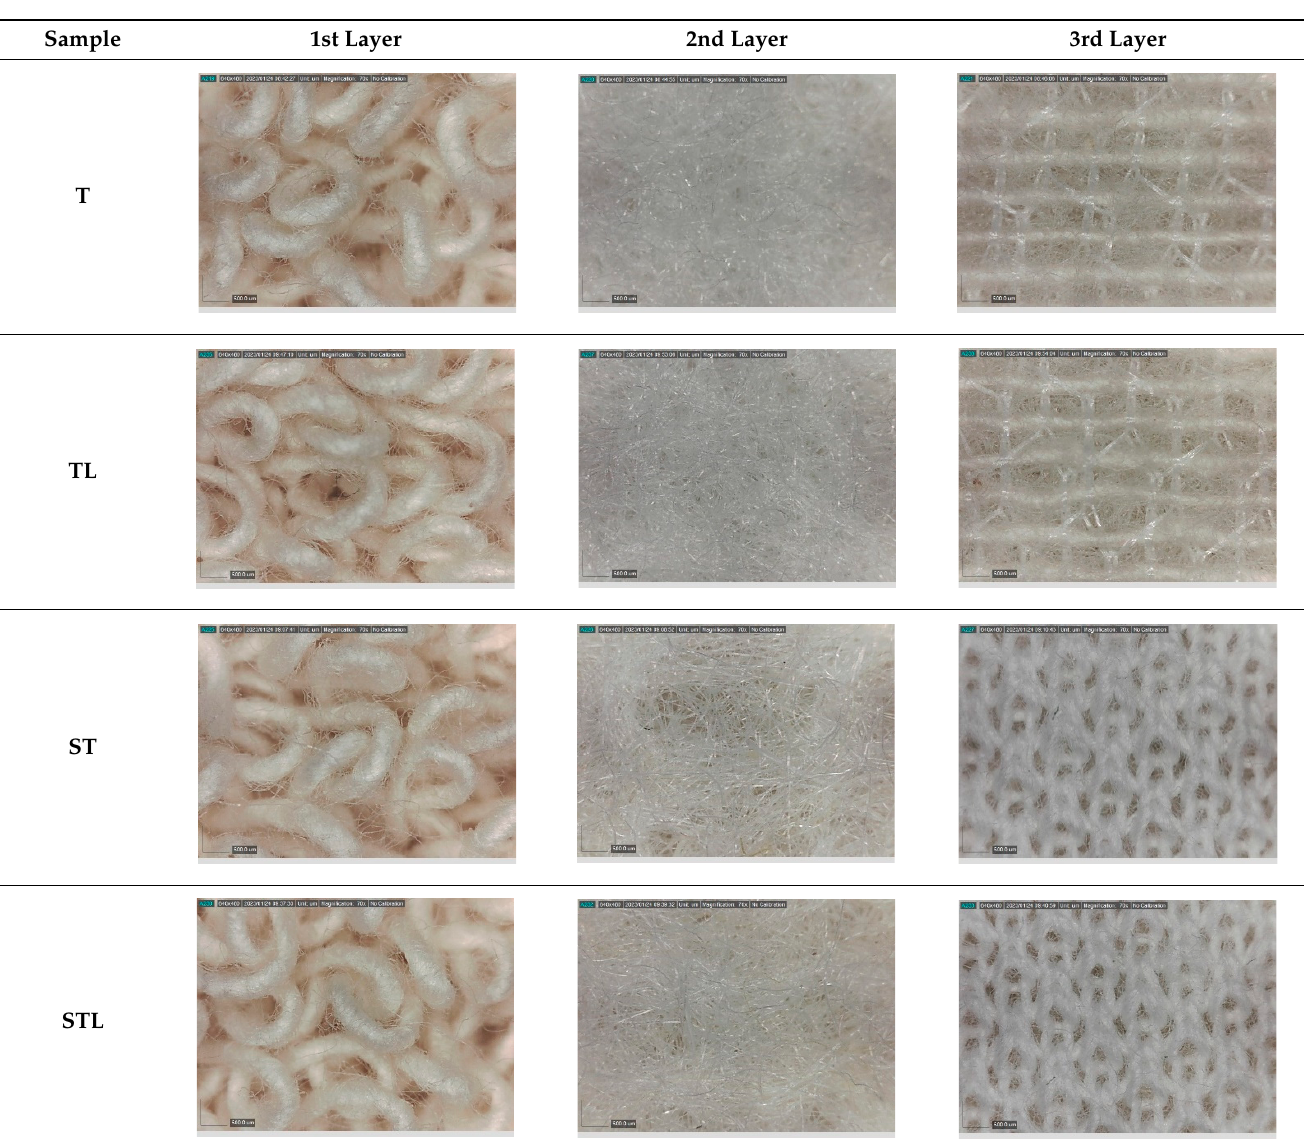
Table 3. Microscopic view of the samples.